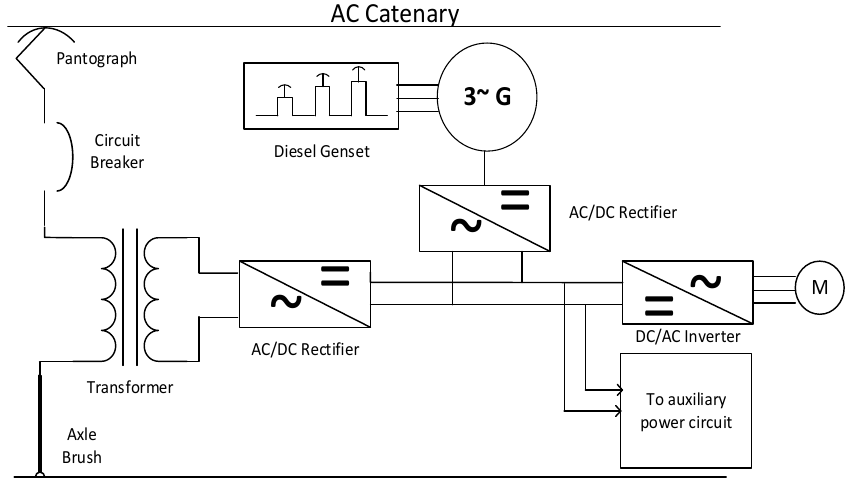
Figure 5. Hybrid diesel–electric multiple-unit system [39].